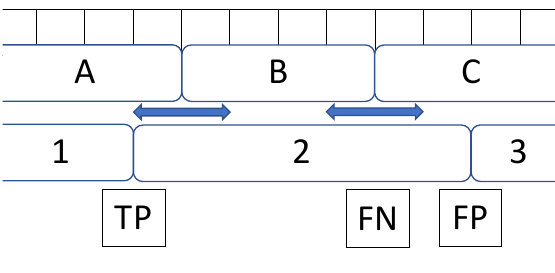
Figure 4. Our approach matches individual activity labels (top: A, B and C) with clustered segments (bottom: 1, 2 and 3) to score transitions as true positives, false positives or